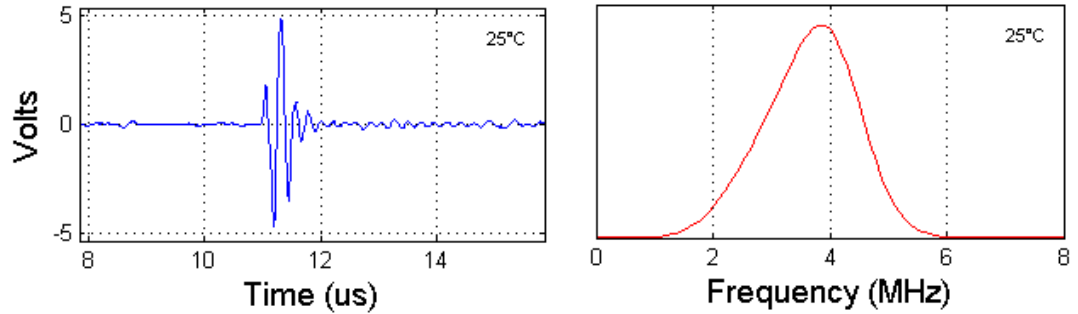
Figure 5. Time and frequency domain signal from backwall echo of steel test block for LiNbO 3 brazed with Al-665 (room temperature test).